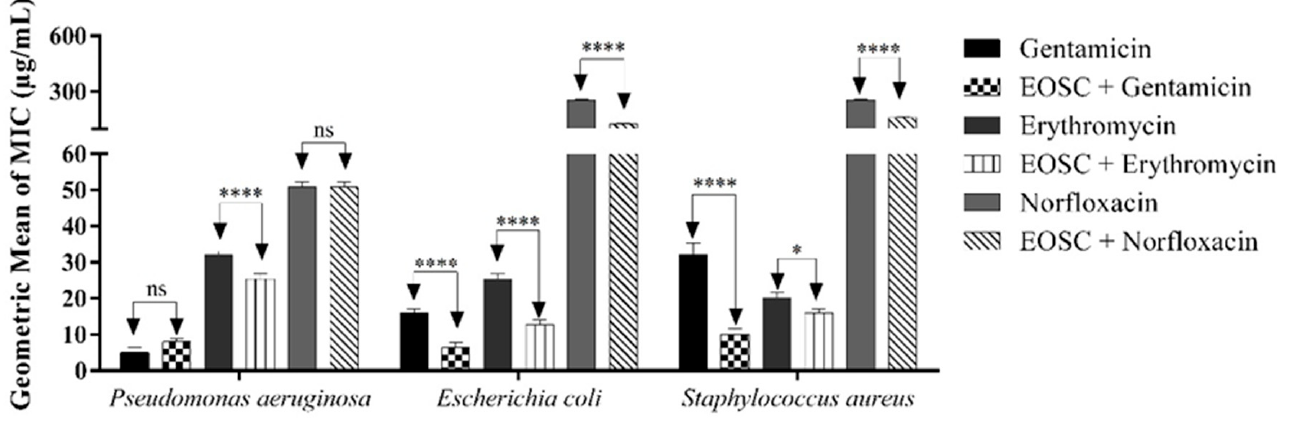
Figure 1. Ability of the EOSC at a subinhibitory concentration of 128 µg/mL (MIC/8) to potentiate the action of antibiotics against multidrug-resistant bacterial strains. * = 0.05; **** = 0.0001; ns = non-significant.